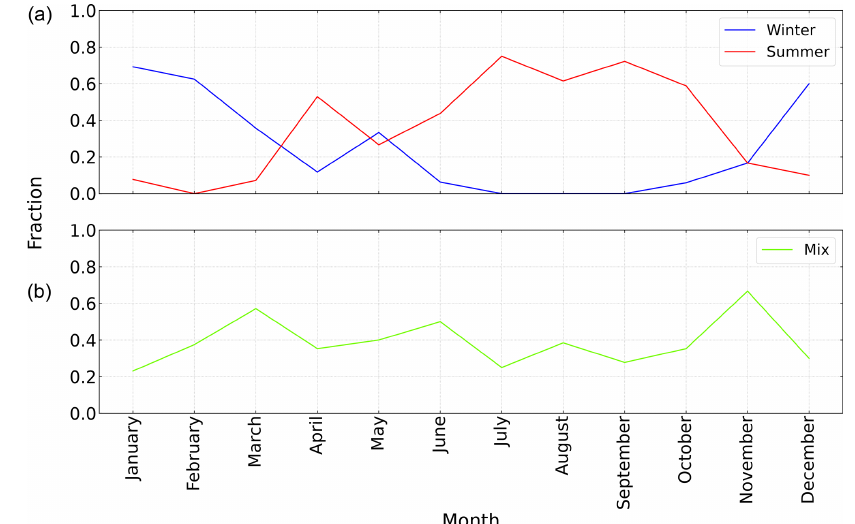
Figure 3. Time series of fractions of Fletcher type (winter) shown in blue, Cooper type (summer) shown in red, both in panel (a) , and shown in light green for mix type in panel (b) . Details of the number of types in each month are shown in Table